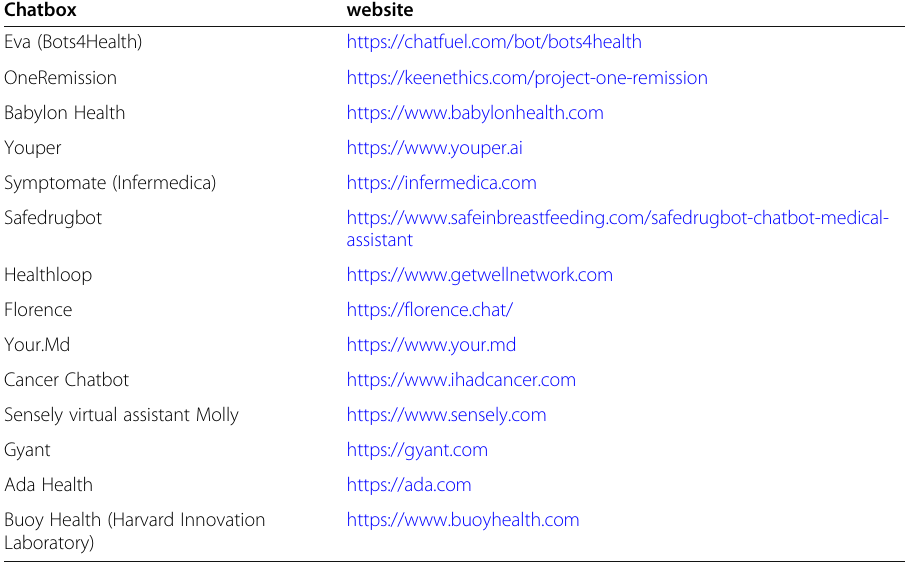
Table 2 main chat box and corresponding website